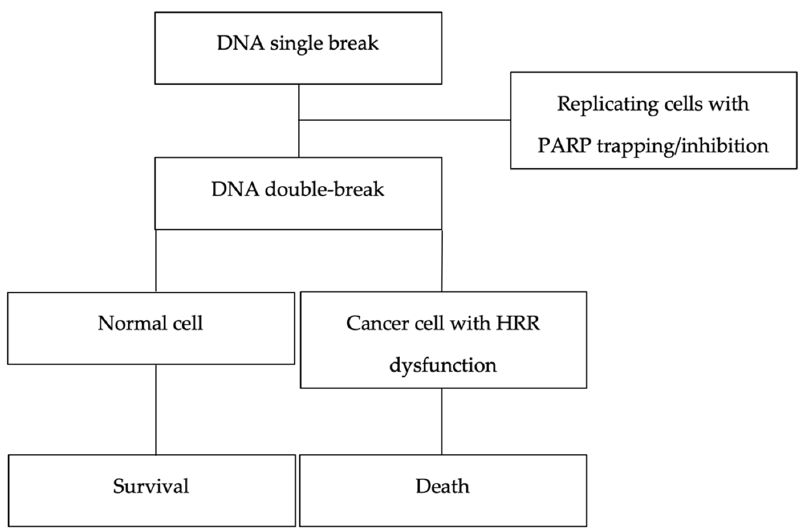
Figure 1. A synthetic lethality therapeutic approach: poly(ADP) ribose polymerase inhibitors (PARPi) for the treatment of cancers with a deficient homologous recombination repair (HRR) pathway. Neither PARPi nor HRR deficiency (HRD) alone is lethal, but the inadequate repair of double-strand breaks found in HRR-deficient cells renders them sensitive to PARP inhibition. Table 1. Associations between pathogenic variants in established breast-cancer-predisposition genes and risk of breast